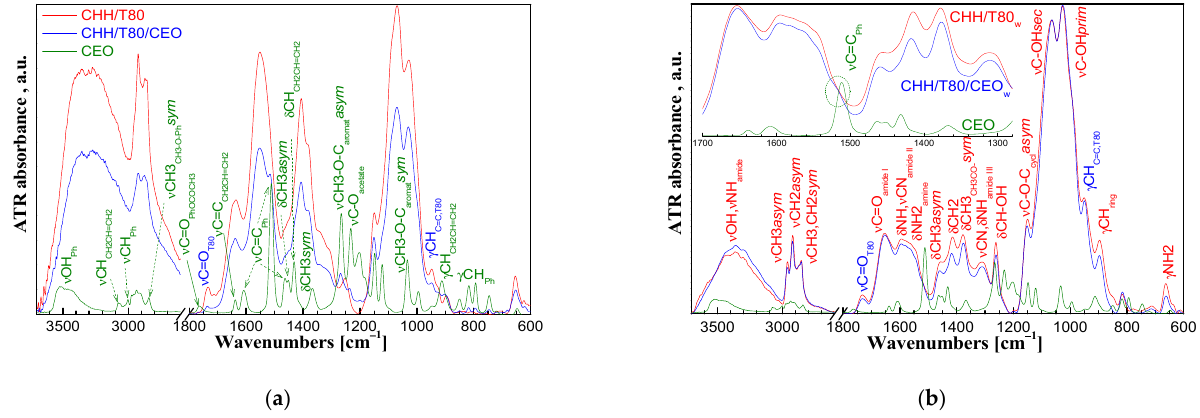
Figure 6. FTIR spectra of clove essential oil (CEO) and chitosan-based xerogels CEO-unloaded (CHH/T80) and CEO-loaded (CHH/T80/CEO) “as prepared” ( a ) and washed ( b